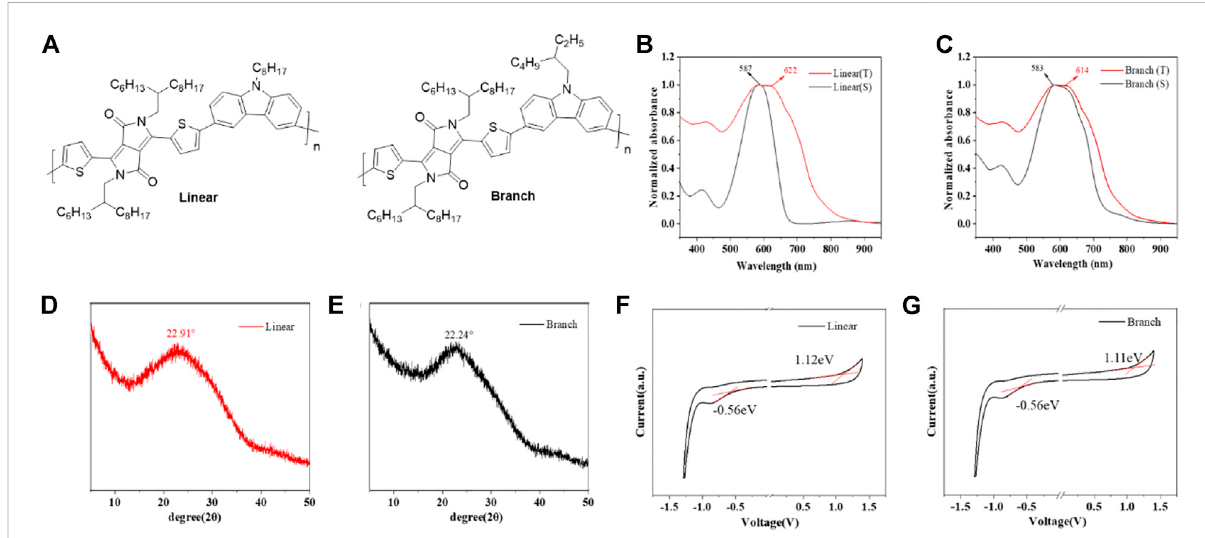
FIGURE 1 (A) Chemical structures of both linear and branch polymers. (B,C) UV/vis absorption spectra of both polymers in solution and thin fi lm state. (D, E) XRD spectra of both polymers. (F,G) Cyclic voltammograms of both polymers (spin-coated thin fi lms on the ITO glass). Electrolyte: 0.1